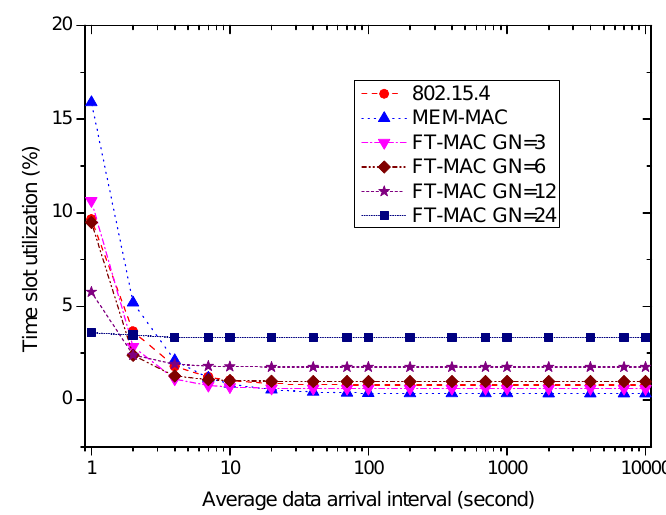
Figure 26. The effect of the average data arrival interval on time slot